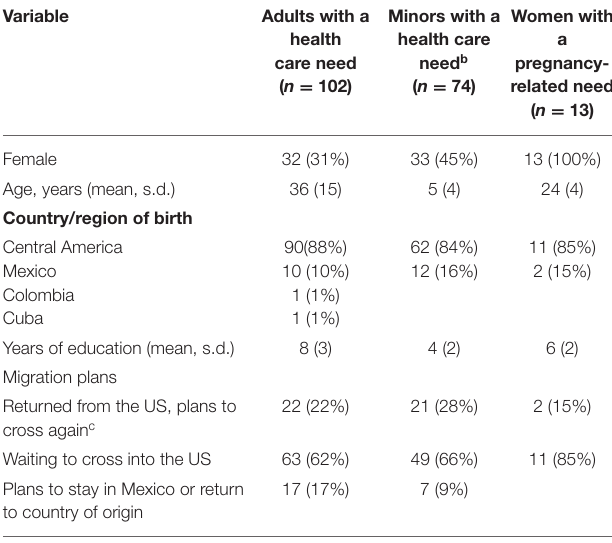
TABLE 1 | Characteristics of migrants surveyed in shelters ( n = 189) a , by